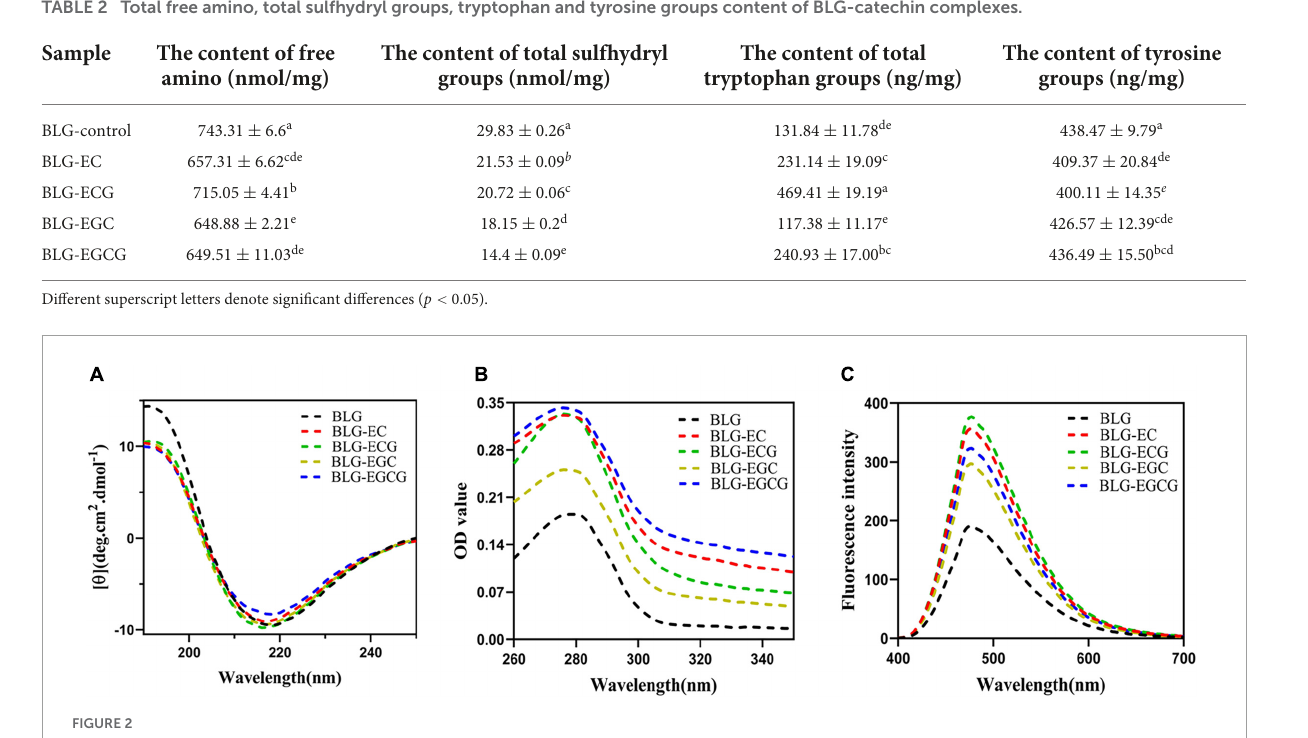
TABLE 2 Total free amino, total sulfhydryl groups, tryptophan and tyrosine groups content of BLG-catechin complexes.